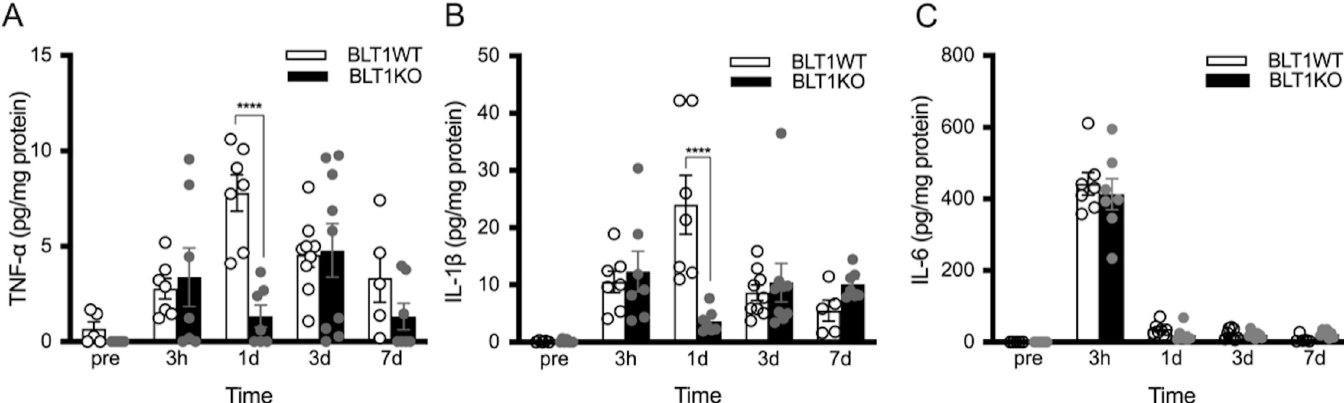
Fig 4. Level of inflammatory cytokines after plantar incision by time course. Cytokine levels in the planter tissue at pre-incision, 3 hours, and 1 and 7 days after the paw incision are shown. A, IL-1 β . B, TNF- α . C, IL-6. In BLT1KO mice, IL-1 β and TNF- α levels 1 day after the incision were significantly lower than those in BLT1WT mice. No significant difference in IL-6 levels was found between the groups. Data are shown as means ± SEM (n = 5–7 per group). A two-way ANOVA with Bonferroni post hoc tests was used for statistical analysis. ���� p < 0.0001 vs. BLT1WT mice.